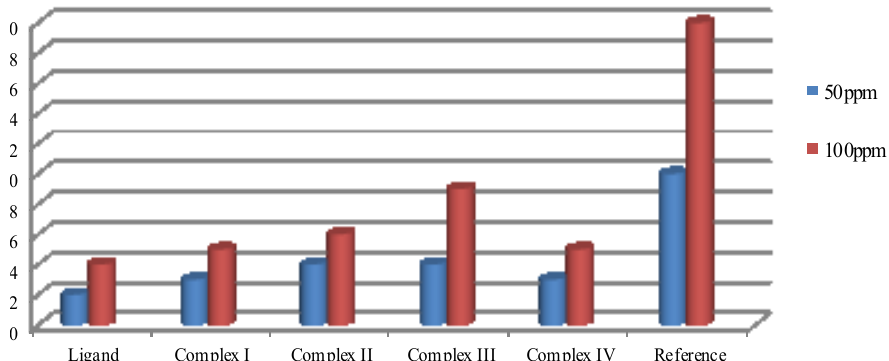
Figure 5b. Effect of different concentration of ligand and complexes with Staphylococcus